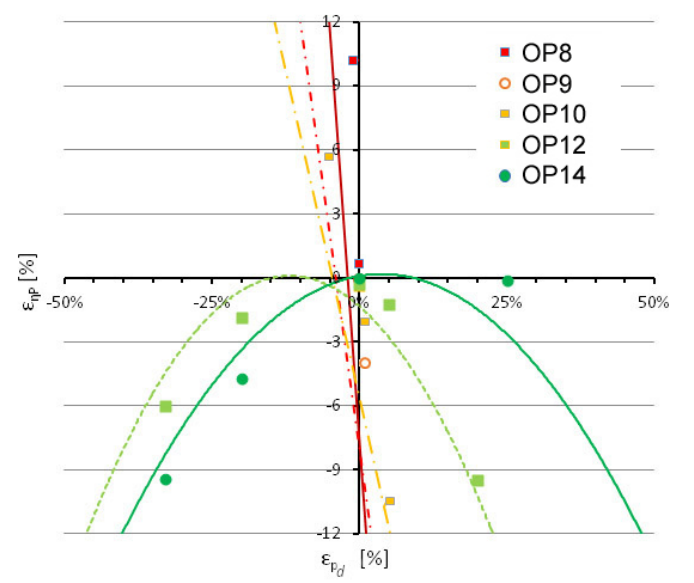
Figure 8. Sensitivity analysis of the algorithm regarding the determination of the pump efficiency (cid:101) η for deviations in the reading of the discharge pressure (cid:101) p OP12 and